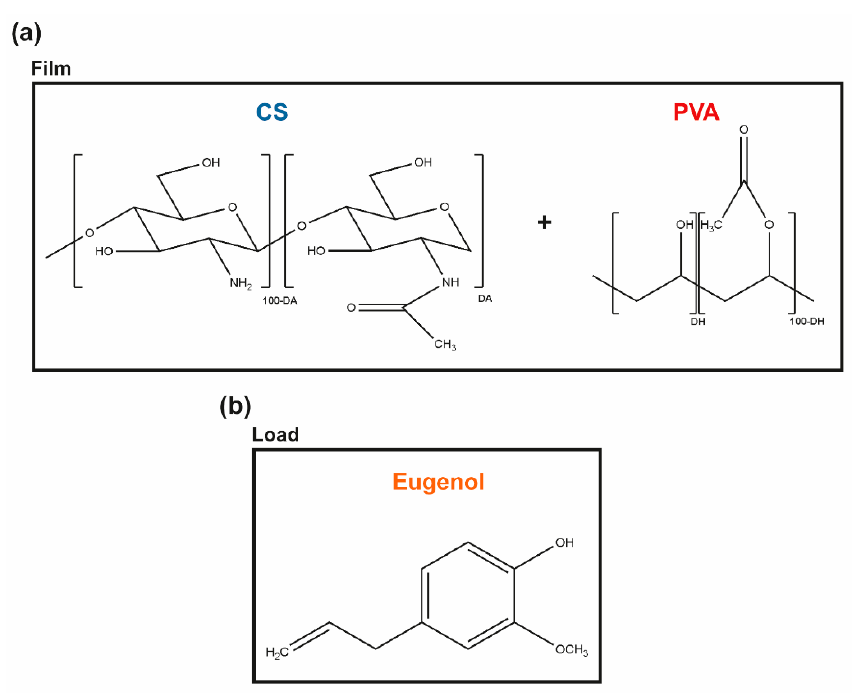
Figure 1. Molecular units forming the ( a ) CS and PVA polymeric matrix, and ( b ) the main phenolic component of CLO and CO, the eugenol, thereby representing the hydrophobic load.